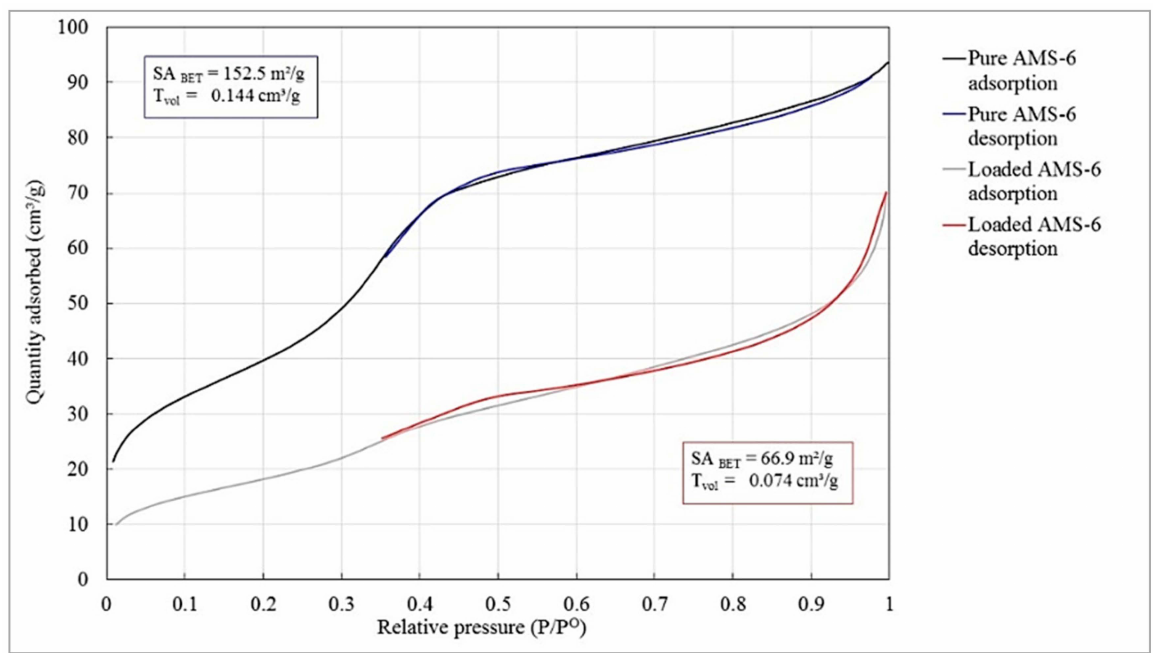
Figure A18. Nitrogen adsorption/desorption isotherm curves of pure AMS-6 and loaded AMS-6-Dox nanoparticles. The very narrow hysteresis loop where the plotted adsorption and desorption curves are close together results from the fact that the pore width of 3.81 nm is very small.